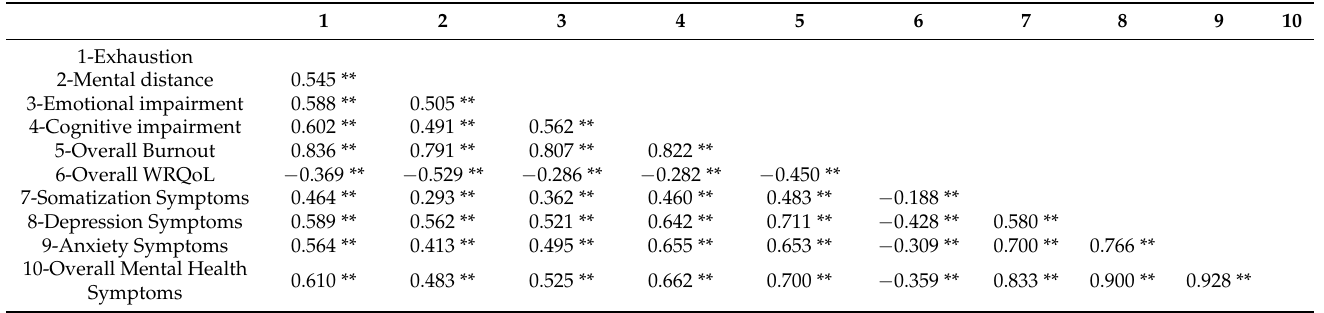
Table 4. Correlation matrix.